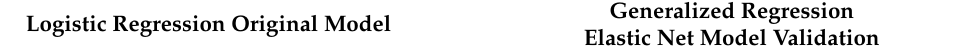
Table 5. Significant factors contributing to the differences between internet-based application against Nutrition Data System for Research on